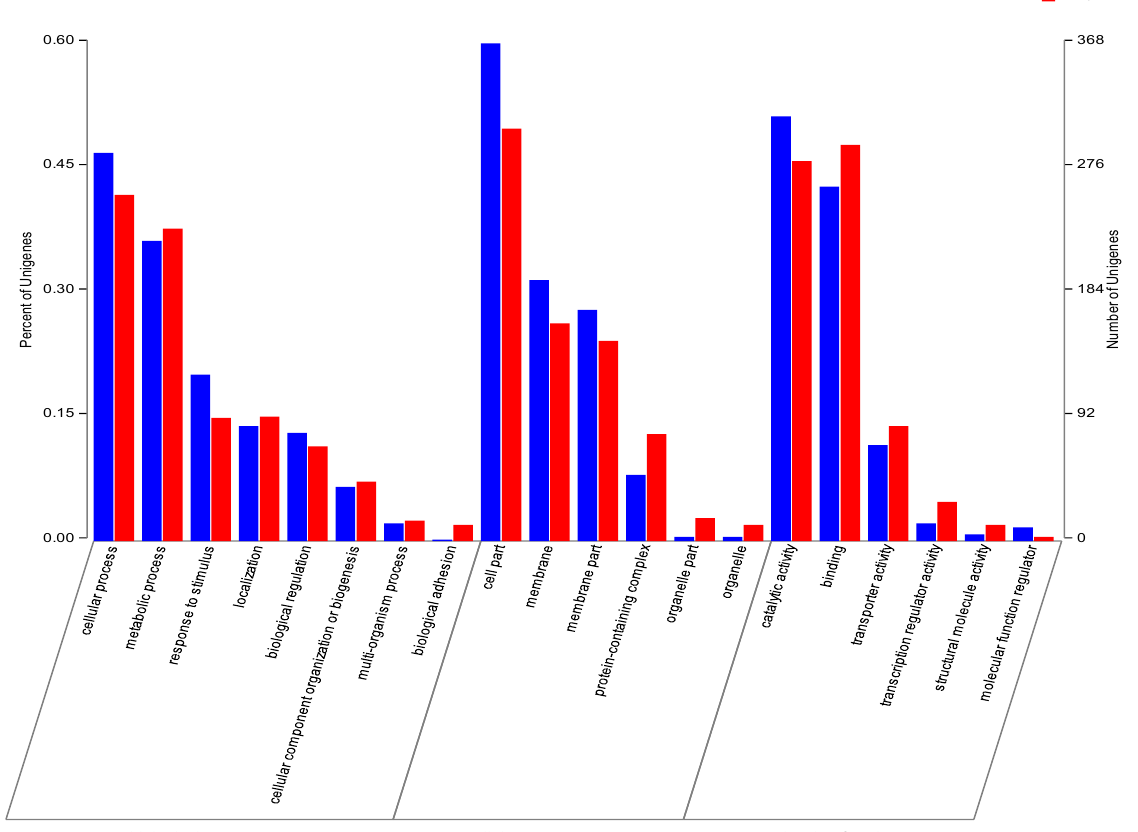
Figure 4. GO enrichment analysis histogram of DEGs. The abscissa represents the three branches of GO, namely biological processes, cell components, and molecular functions, and further level 2 classification; the ordinate represents the relative proportion of genes.